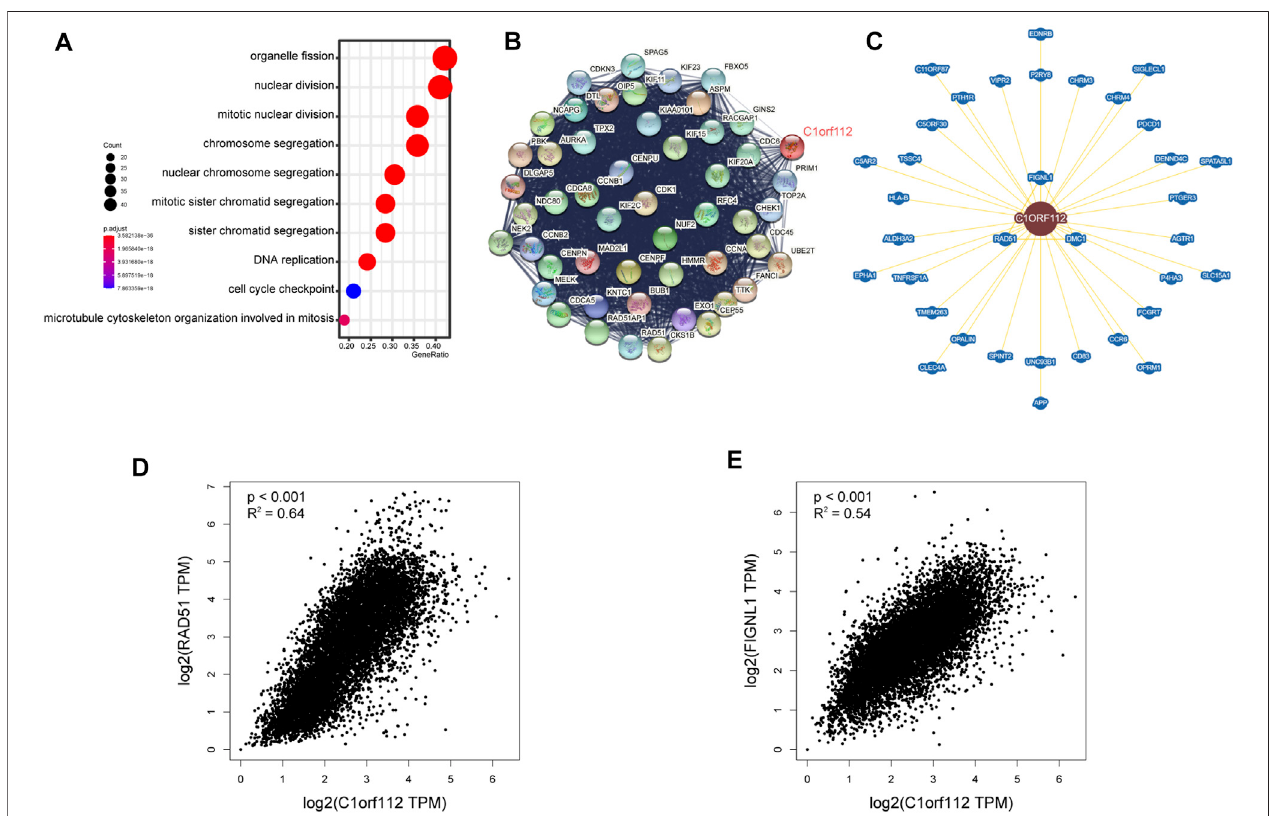
FIGURE 6 | C1ORF112 -related gene enrichment analysis. (A) Gene Ontology (GO) analysis of the top 100 genes co-expressed with C1ORF112 obtained by the GEPIA2. (B) Co-expressionnetworkof50genesco-expressedwith C1ORF112 obtainedbytheSTRINGtool. (C) C1ORF112 -proteininteractionsobtainedbyBioGRID. (D,E) Correlation analysis between C1ORF112 and RAD51 and FIGNL1 conducted by GEPIA2 across all tumor samples from TCGA.